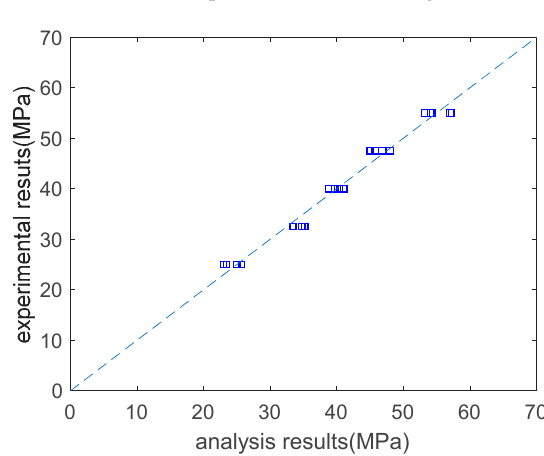
Figure 2. Experimental results vs. analysis results on strength.